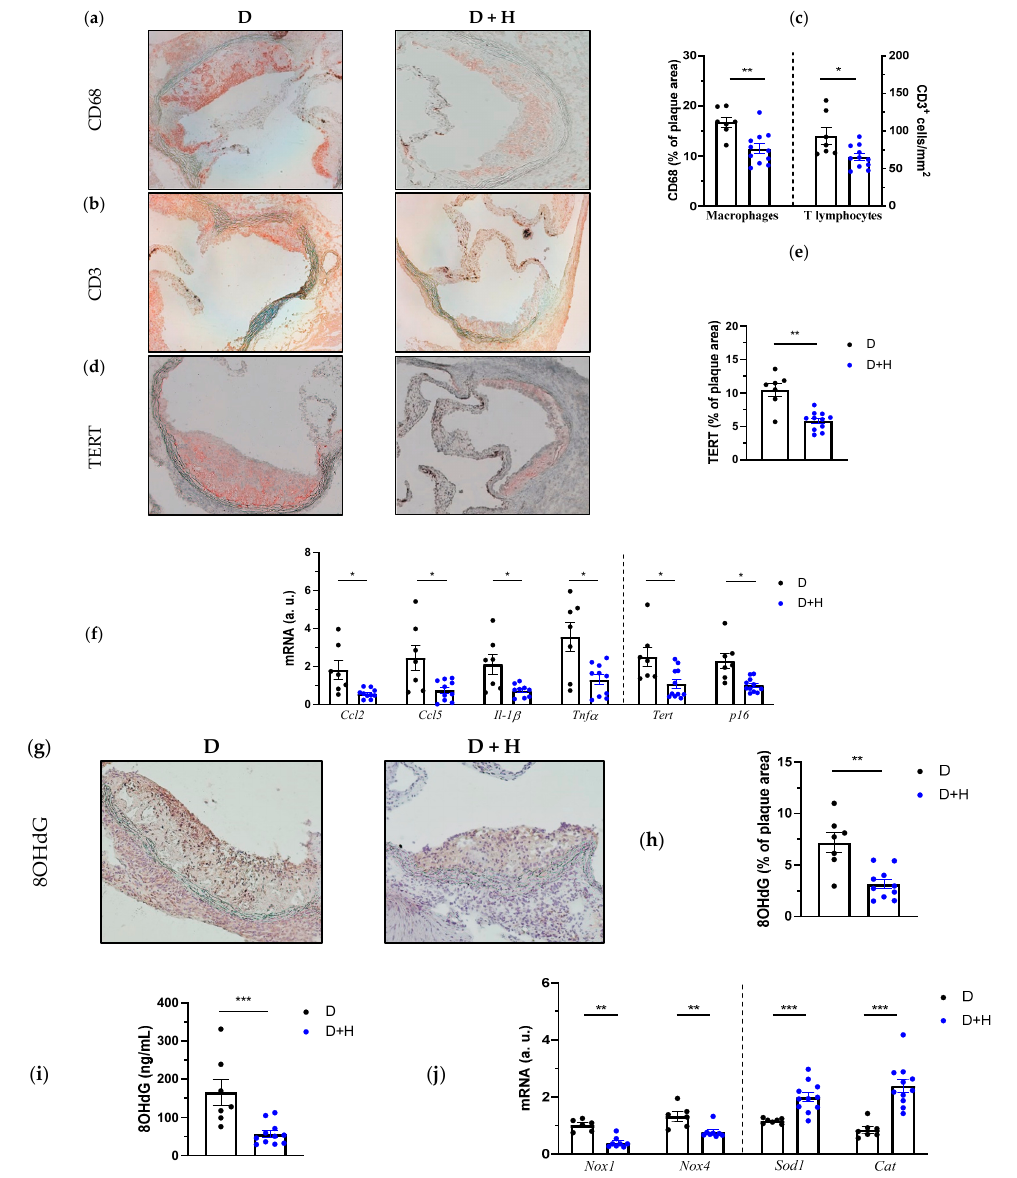
Figure 5. Attenuated inflammation, senescence and oxidative stress in aortic lesions of hidrosmin- treated mice. Representative images (magnification ×200) for CD68+ macrophages ( a ) and CD3+ T cells immunostaining ( b ) in aortic lesions from diabetic ApoE KO mice (untreated, D; hidrosmin treatment, D + H) and quantification ( c ). ( d ) Representative images (magnification ×200) of TERT immunostaining and quantification ( e ). ( f ) Real-time PCR analysis of inflammatory ( Ccl2 , Ccl5 , Il-1 β and Tnf α ) and senescence ( Tert and p16 ) genes in mouse aorta. Values normalized to 18S rRNA are expressed as arbitrary units (a.u.). ( g ) Representative images (magnification ×200) of 8OHdG immunoperoxidase in mouse aorta and quantification of positive staining ( h ). ( i ) Quantification of 8OHdG levels in serum samples by ELISA method. ( j ) Gene expression analysis of pro-oxidant ( Nox1 and Nox4 ) and antioxidant ( Sod1 and Catalase, Cat ) genes in mouse aorta. Values normalized to 18S rRNA are expressed as arbitrary units (a.u.). Graphs represent individual values and mean ± SEM of each group (D, n = 6–7; D + H, n = 8–11). * p < 0.05, ** p < 0.01 and *** p < 0.001 vs. D group by Mann–Whitney U test.